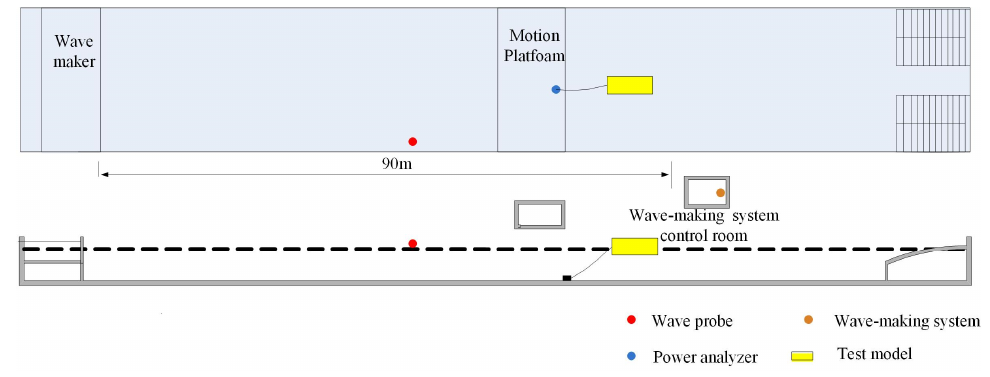
Figure 6. Test layout.